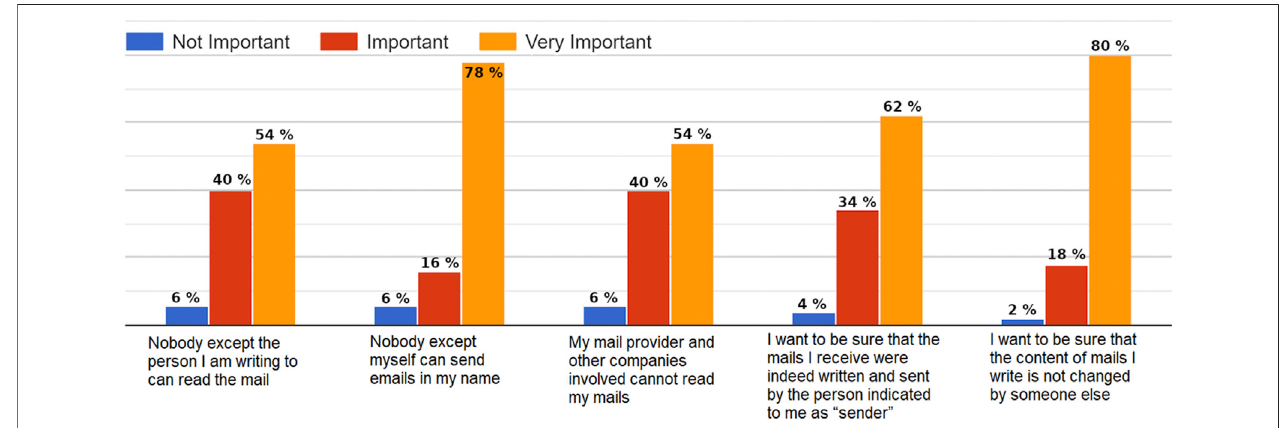
FIGURE 5 | Answers to the question: Please indicate the importance that the following security goals have for you.